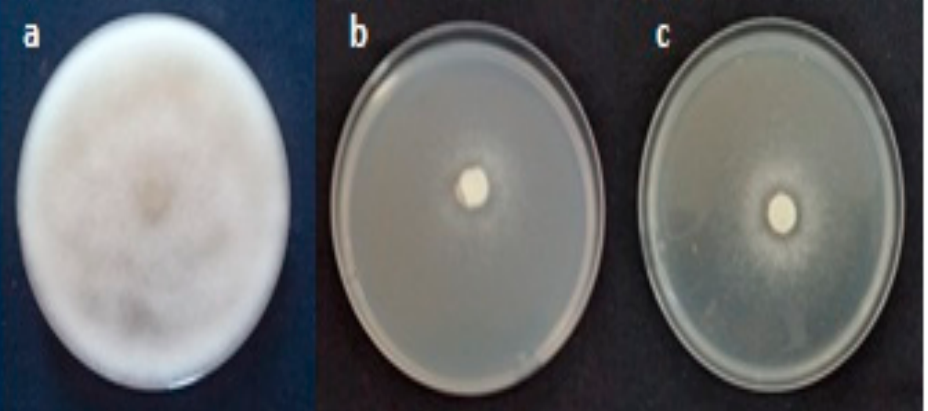
Figure 3. Chromatogram GCA of F7–8 dichloromethane extract fraction of Raphanus raphanistrum recorded on an apolar HP ‐ 5 column.